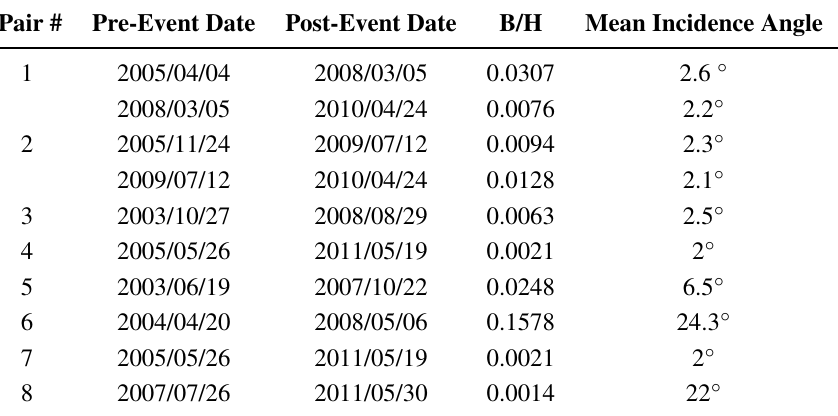
Table 1. SPOT5 images index